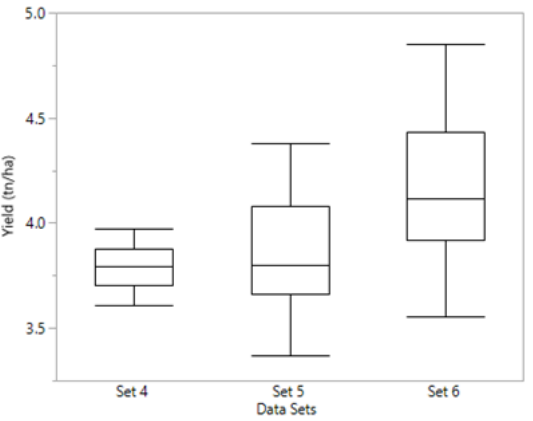
Figure 4. Boxplots for mean grain yield (t ha −1 ) based on family means for each preliminary line set grown at two locations in Kentucky, 2018.